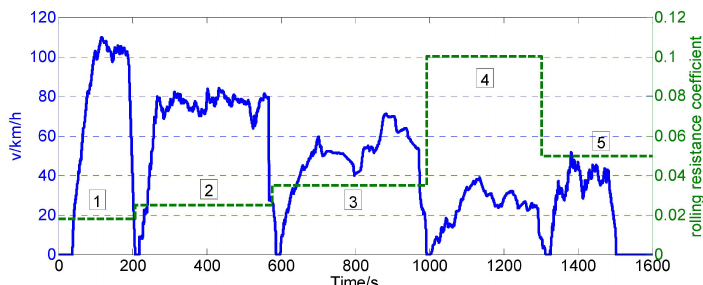
Figure 8. Heavy-duty vehicle driving conditions.